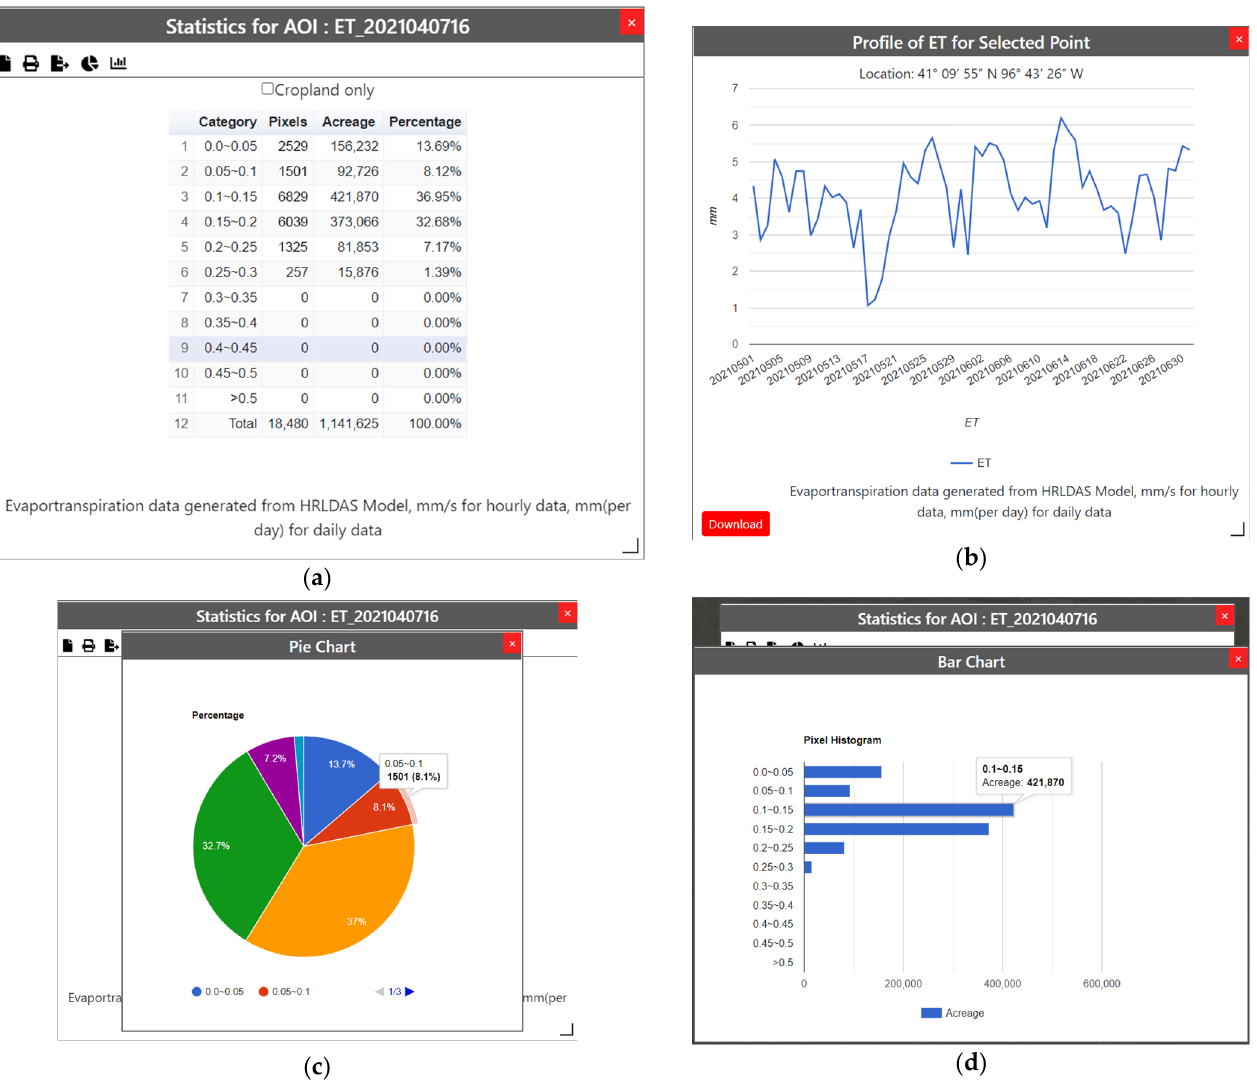
Figure 5. Results table and charts for selected AOI and points returned by provided analysis functions: ( a ) Statistical result of ET in the user-defined AOI; ( b ) Hourly ET time series of line chart of user-selected point; ( c , d ) Pie chart and bar chart of the statistical result in ( a ).